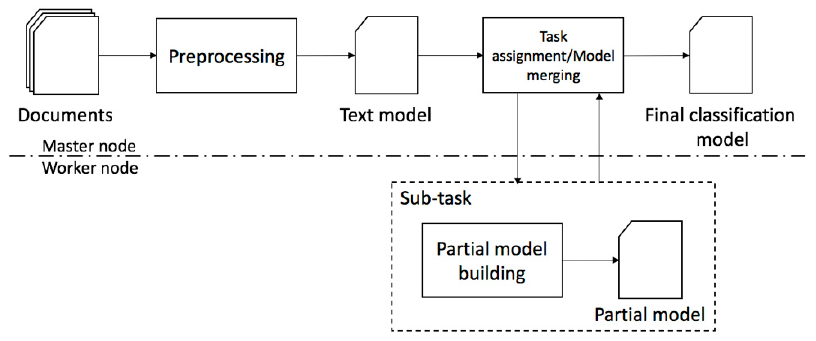
Figure 2. Distributed model building.